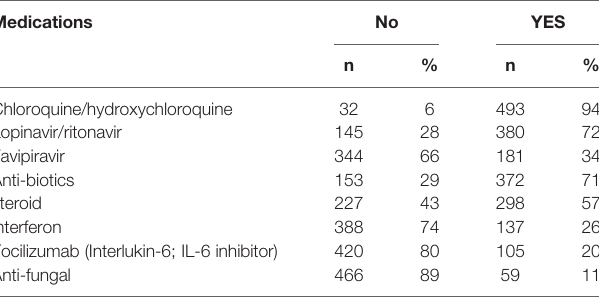
TABLE 6 | Treatment of 525 symptomatic COVID-19